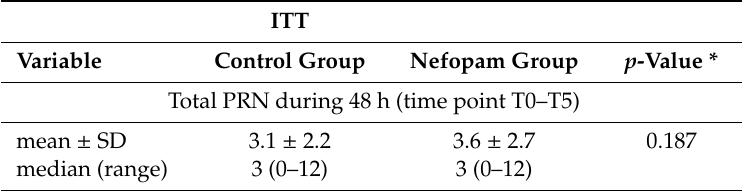
Table 5. Association between nefopam and total number of